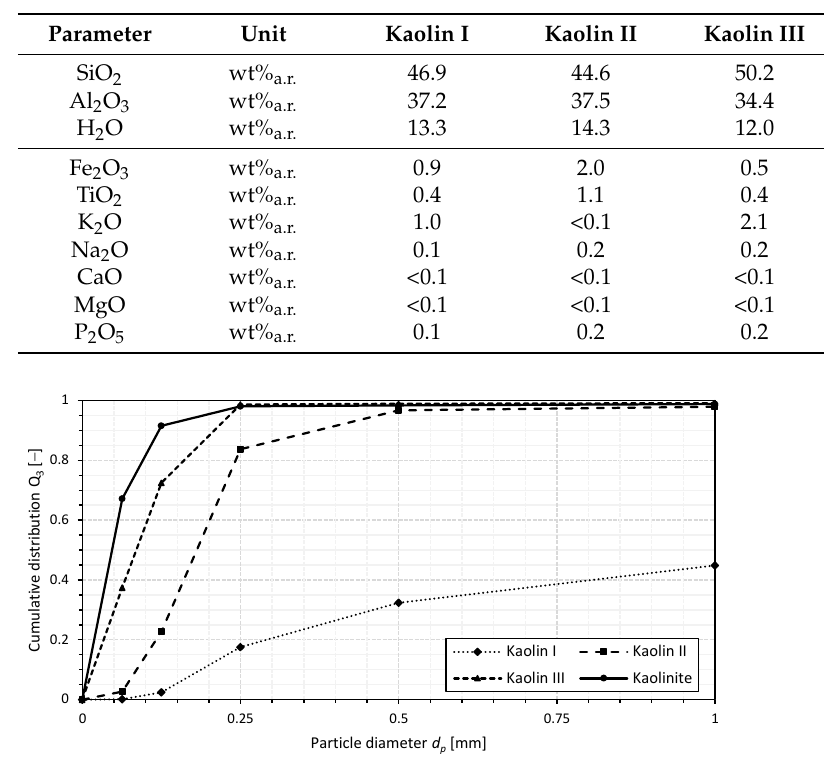
Table 2. Chemical compositions of the aluminum ‐ silicate ‐ based additives Kaolin I, Kaolin II, Kaolin III, and Kaolinite (a.r.: additive as received).